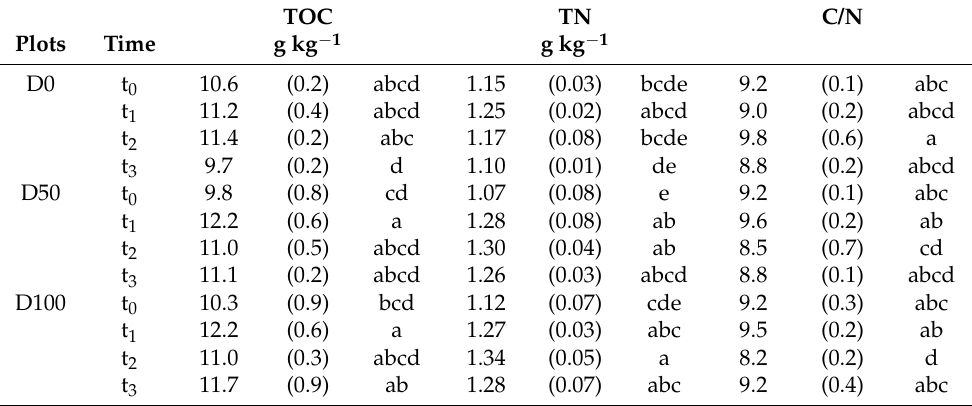
Table 4. Soil total organic carbon (TOC), total nitrogen (TN) and C/N ratio under the different experimental treatments at different sampling times (means followed by standard error in brackets). Different letters indicate statistically significant differences at p ≤ 0.05 (Fisher LSD test). TOC TN C/N